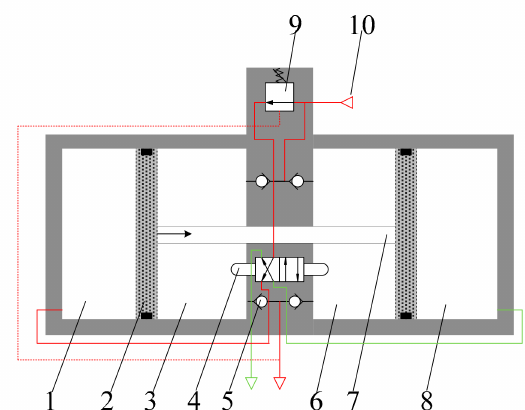
Figure 1. Schematic of booster regulator (VBA). 1-Drive chamber A, 2-piston, 3-booster chamber A, 4-switching valve, 5-check valve, 6-booster chamber B, 7-piston rod, 8-drive chamber B, 9-regulator, 10-air source. The pressure is higher in red lines than in green lines.